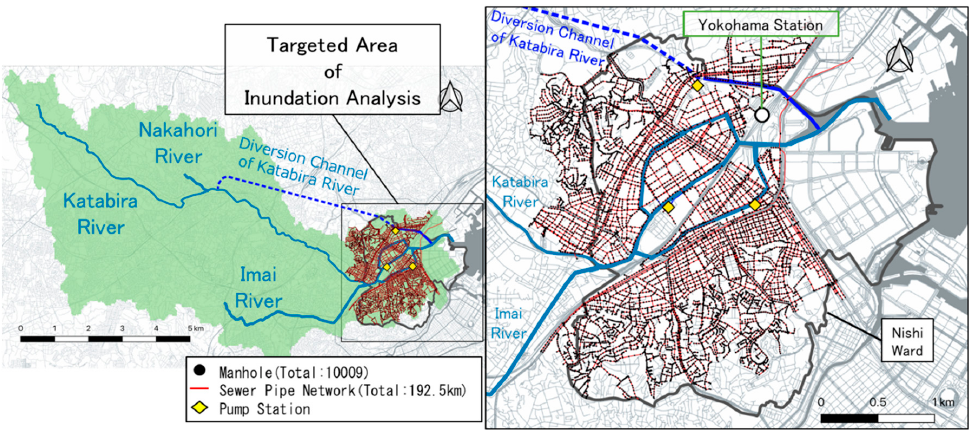
Figure 11. Subject area for calculation.